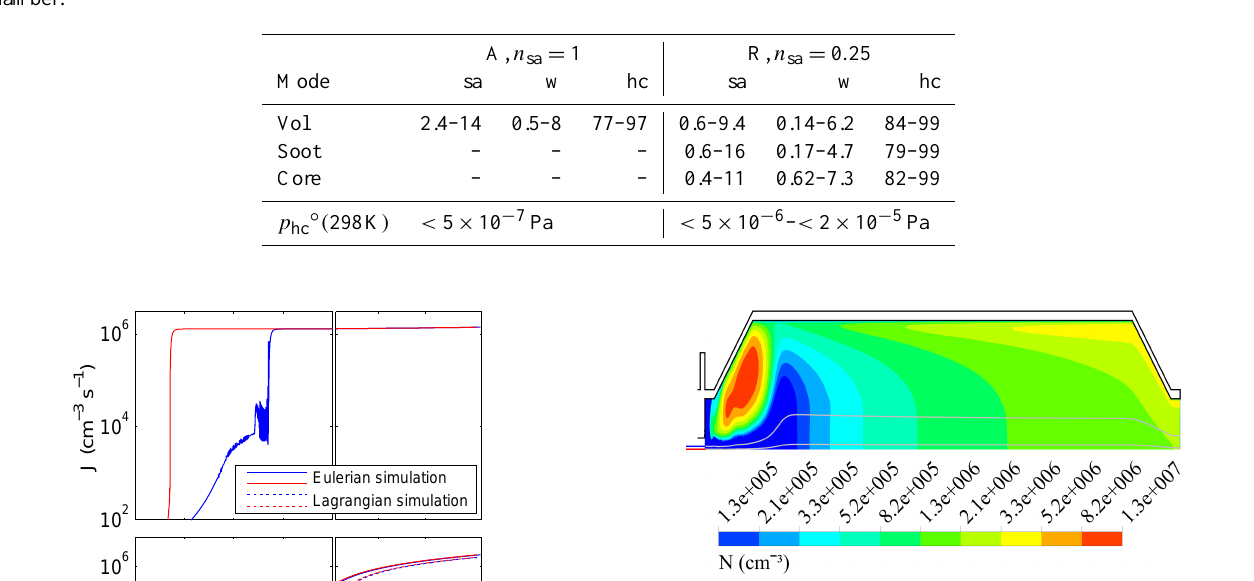
Table 3. Particle liquid part composition (mass %) and the maximum saturation vapor pressures of hydrocarbons at the end of the aging chamber.